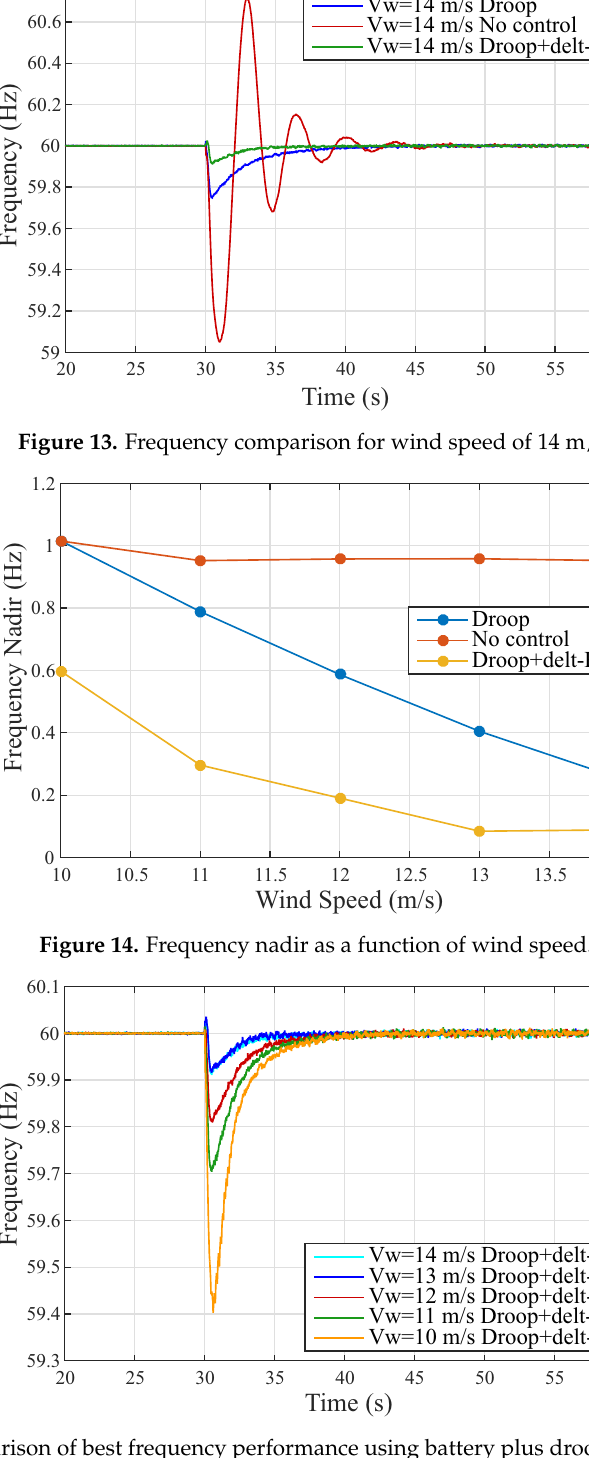
Figure 15. Comparison of best frequency performance using battery plus droop for all wind